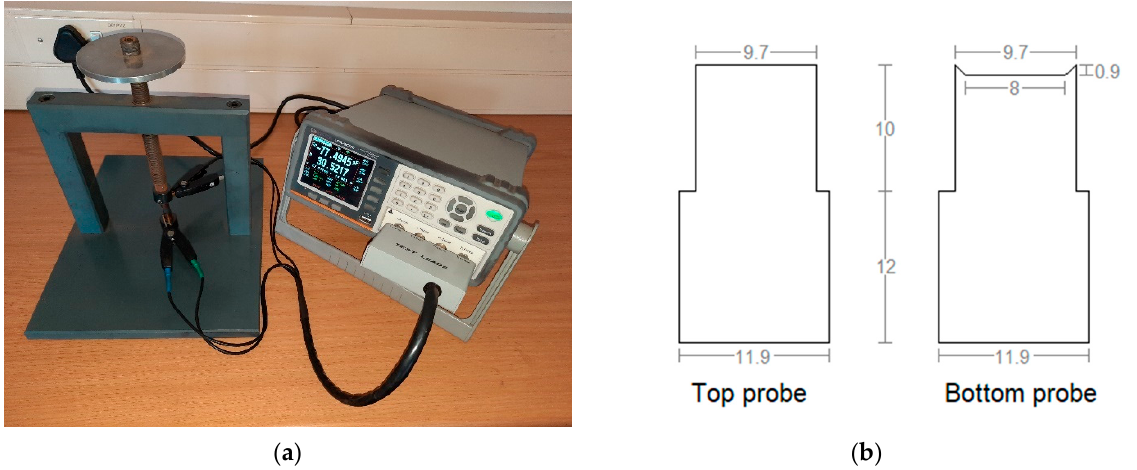
Figure 2. ( a ) Photo indicating the GW Instek resistance precision meter (Model LCR-6020 Series) and two-probe device, similar to the design presented by Heikkilä et al. [16], used to measure electrical resistivity of the cylindrical sample pellets; ( b ) illustration indicating the shapes of the copper probes, in-between which the cylindrical sample pellets were held.